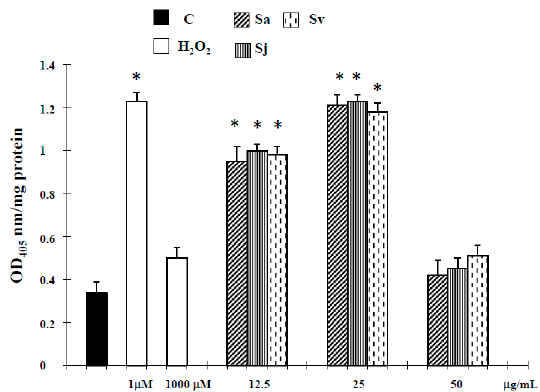
Figure 2. Caspase-3 activity, determined by using the Caspase colorimetric assay Kit (SIGMA RBI St. Louis, MO, USA), in DU-145 cells treated with different concentrations of the essential oils from Sa, Sj and Sv for 72 h. The values are the mean ± standard deviation (SD) of three experiments performed in quadruplicate. * Significant vs. control untreated cells ( p < 0.001).